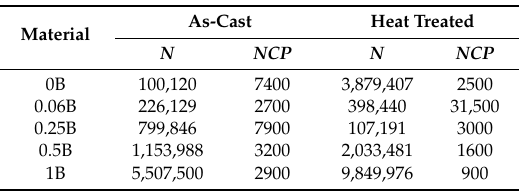
Table 3. Number of cycles to failure ( N ) and approximate number of cycles during macroscopic crack propagation ( NCP ) at 615